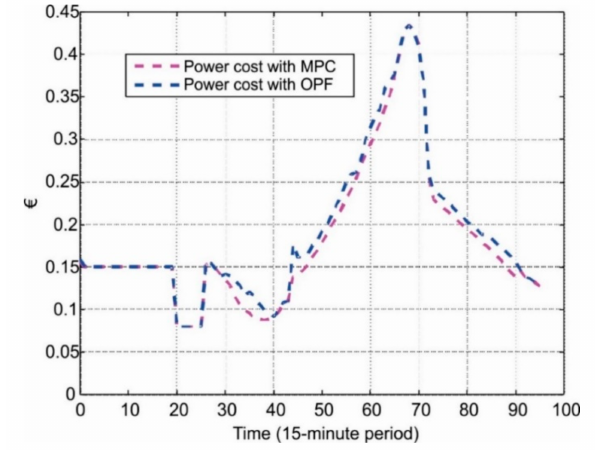
Figure 12. Power cost with MPC and